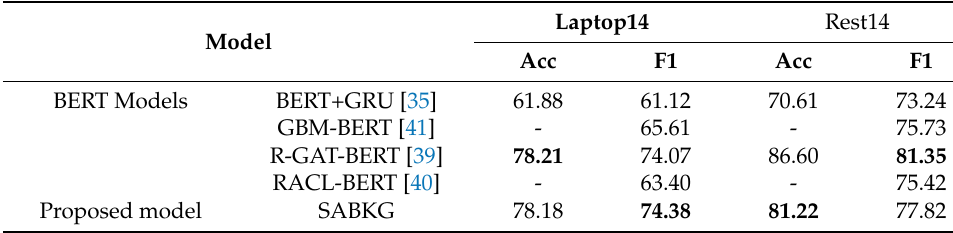
Table 3. Comparison with BERT-BASED